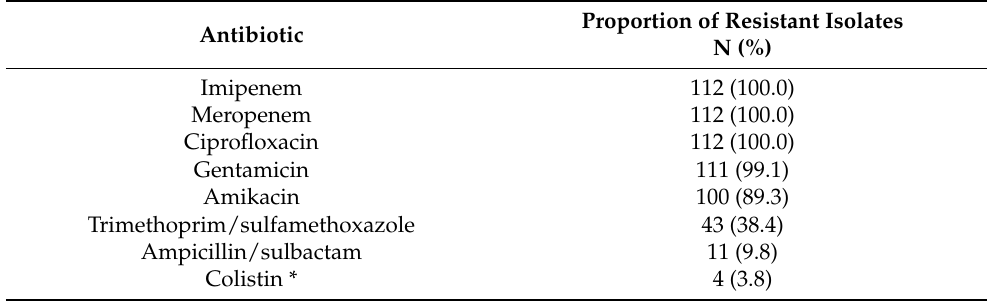
* The number of isolates tested for colistin varies (N =